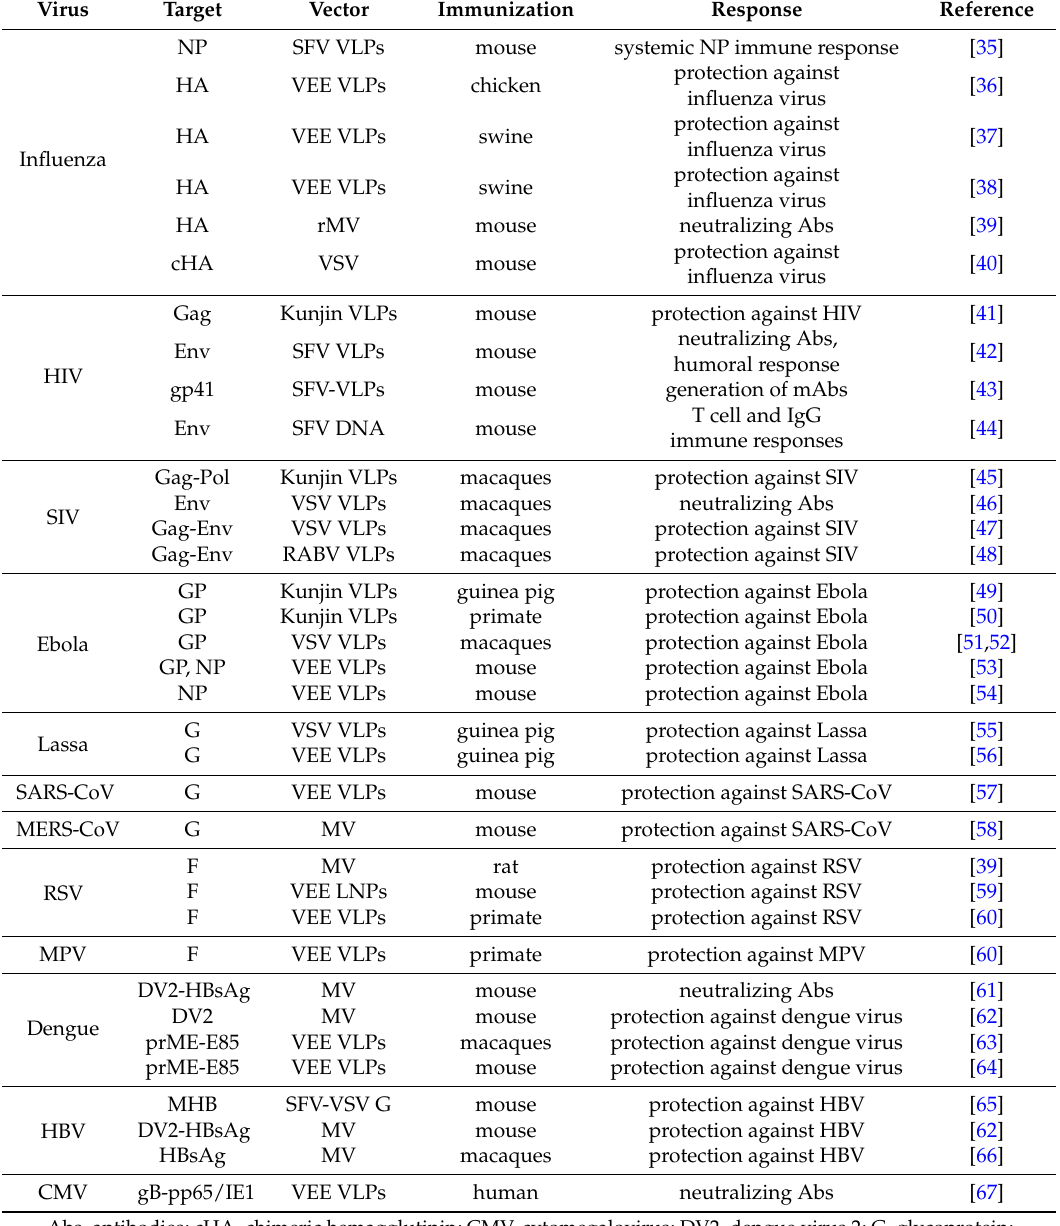
Table 1. Self-replicating RNA viral vector-based immunizations against viral